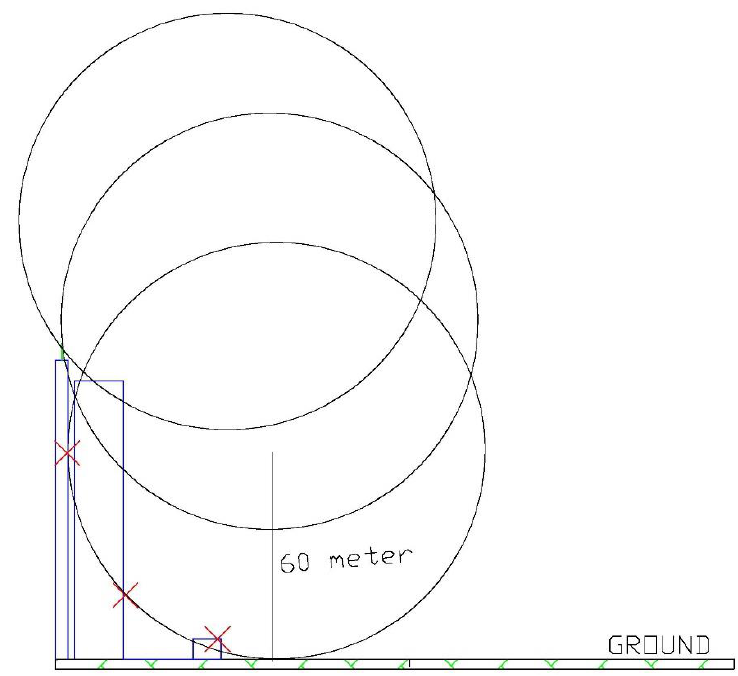
Figure 4. Model of lightning protection zone of the prilling tower with RSM.